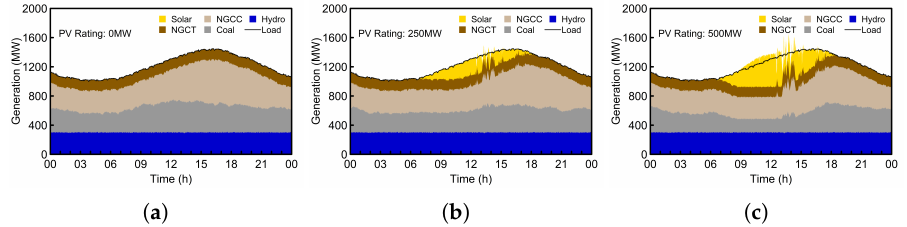
Figure 6. Minute-to-minute (M-M) unit economic dispatch highlighting the impact of increasing PV penetration on an example generation portfolio. The results indicate that large PV penetrations may lead to both over- and under-generation scenarios where combined power from units cannot match demand. The presented analysis include ( a ) no PV, ( b ) 250 MW PV, and ( c ) 500 MW PV penetration case